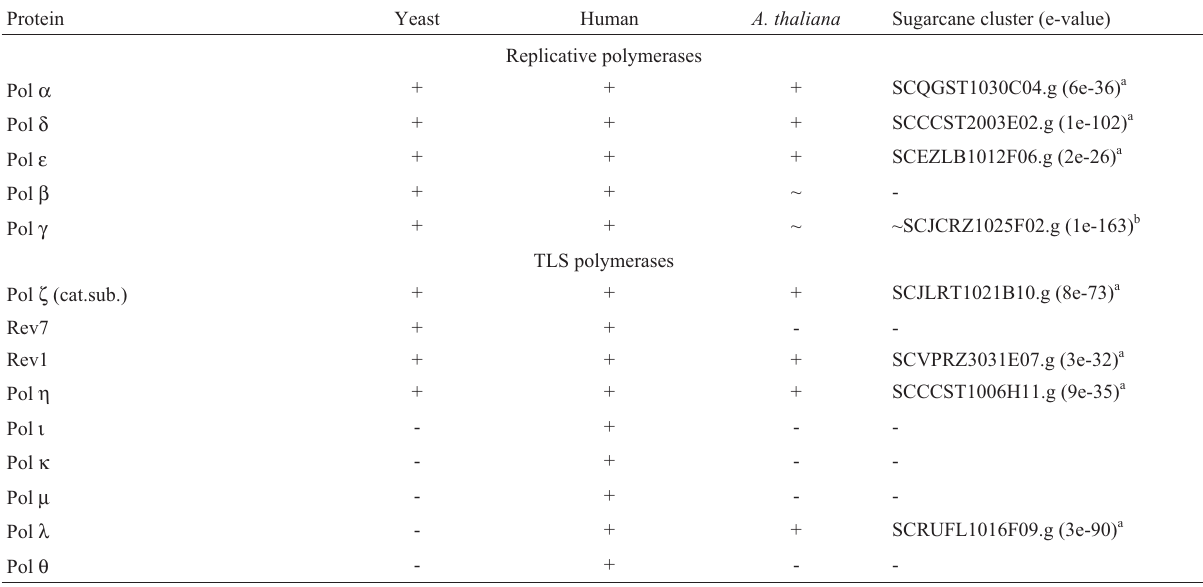
Table VI - Comparative analysis of polymerases in different